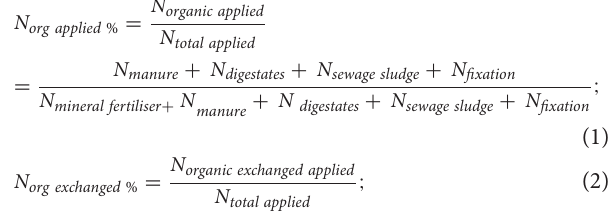
Frontiers in Sustainable Food Systems |